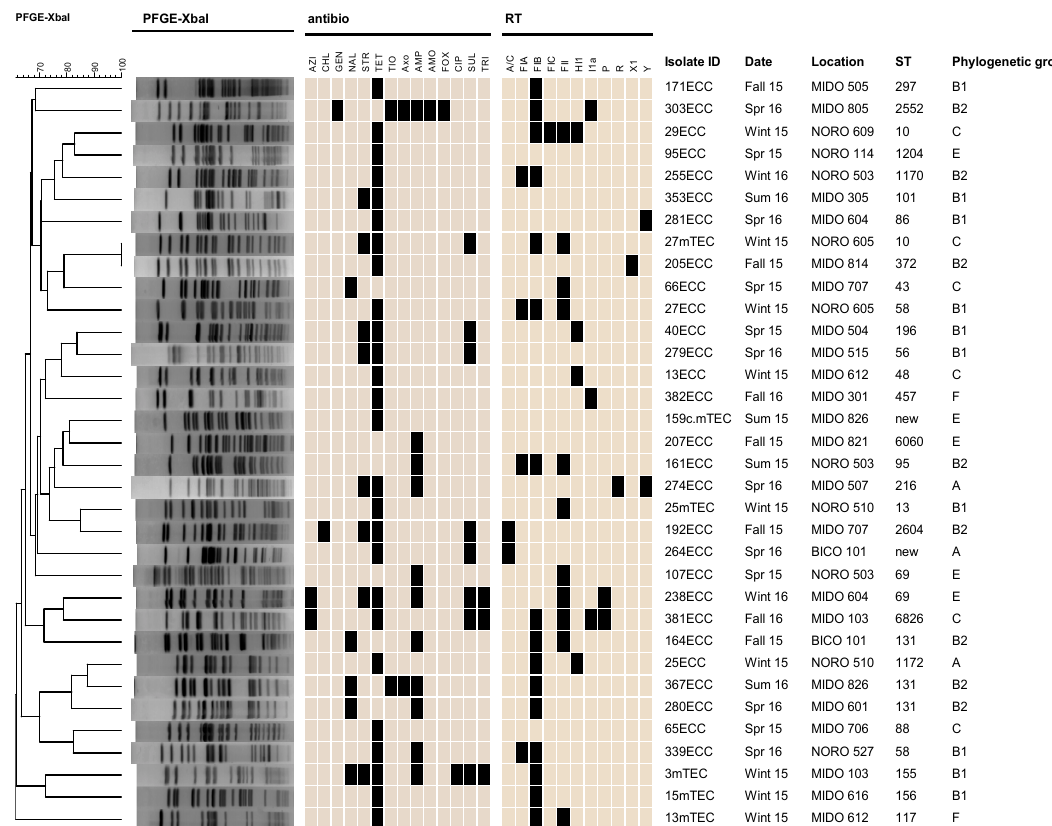
Figure 2. Dendrogram of 34 antimicrobial-resistant E. coli isolates recovered from Upper Oconee Watershed near Athens, GA. Their pulsed-field gel electrophoresis (PFGE) analysis, antimicrobial resistance patterns, replicon types, multilocus sequence typing (MLST), and phylogenetic groups are shown. Black boxes represent resistance to antimicrobials or the presence of plasmids, and beige boxes represent susceptibility to antimicrobials or absence of plasmids. Antimicrobials: azithromycin (AZI), chloramphenicol (CHL), gentamicin (GEN), nalidixic acid (NAL), streptomycin (STR), tetracycline (TET), ceftiofur (TIO), ceftriaxone (AXO), ampicillin (AMP), amoxicillin / clavulanic acid (AMO), cefoxitin (FOX), ciprofloxacin (CIP), sulfisoxazole (SUL), and trimethoprim / sulfamethoxazole (TRI).